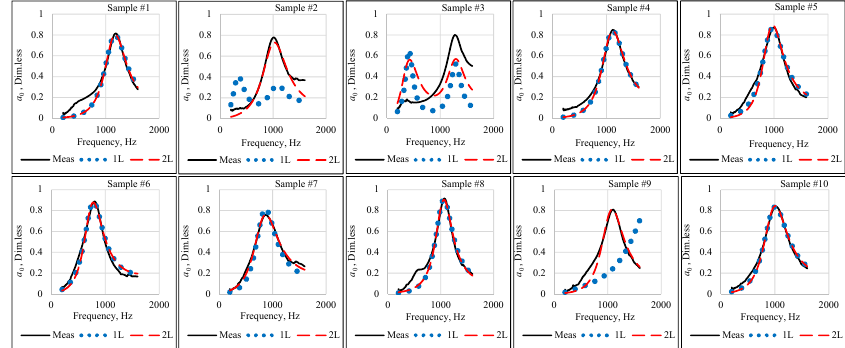
Figure 5. a 0 plots (optimization in 300–1600 Hz, measured resistivity)